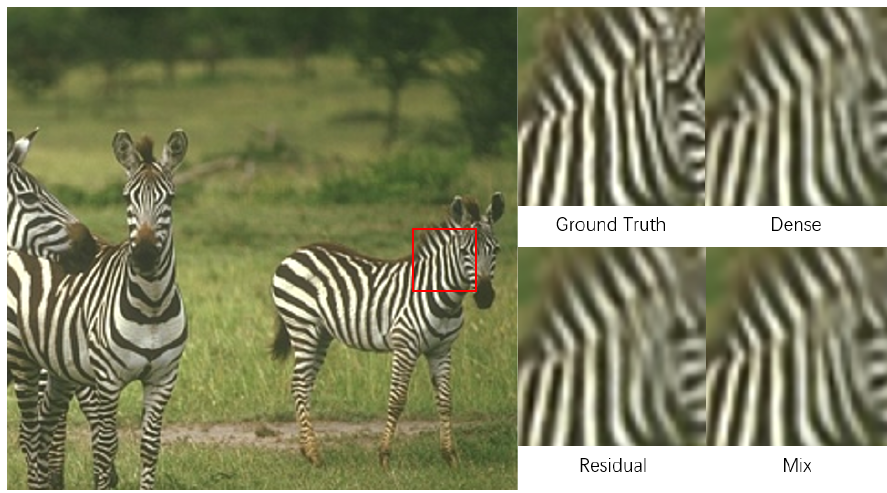
Figure 9. Visual comparison of Mix, Dense and Residual network structure.